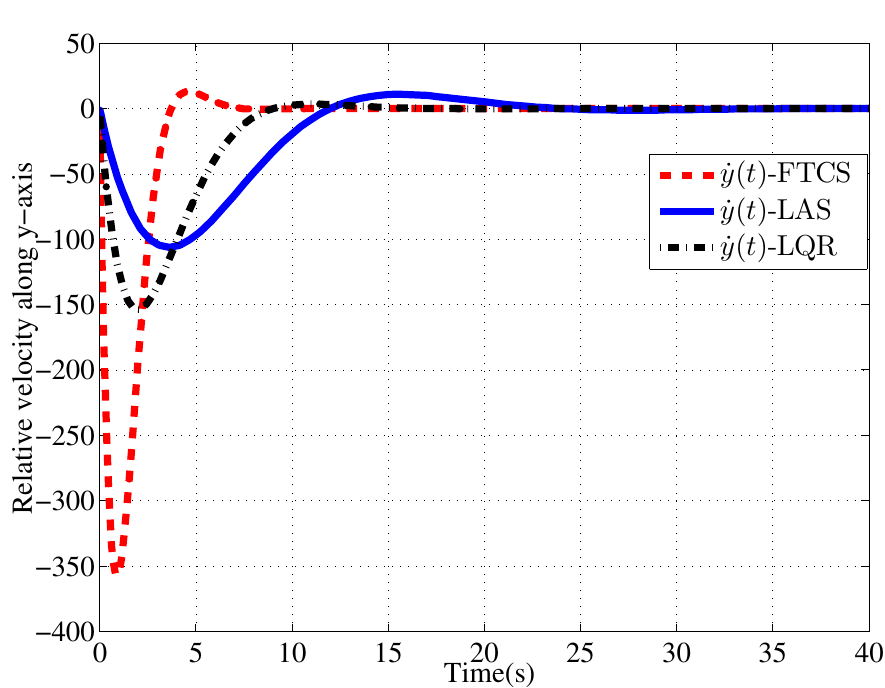
Figure 7. Relative velocity along y -axis under different control laws.